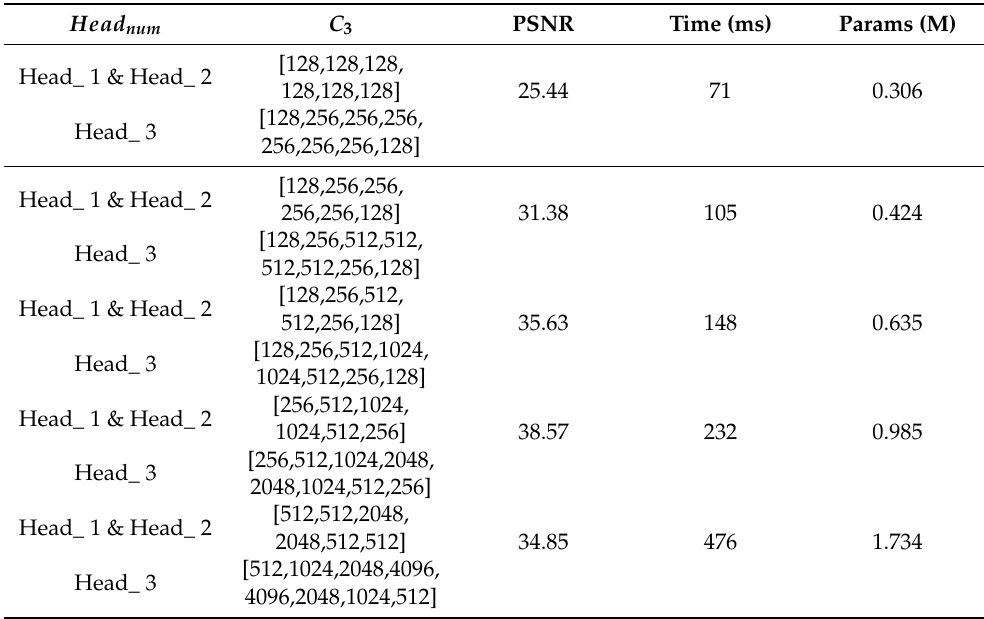
Table 5. Ablation experiments for the channels C 3 in each Stage on the self-built dataset for the maritime image dehazing